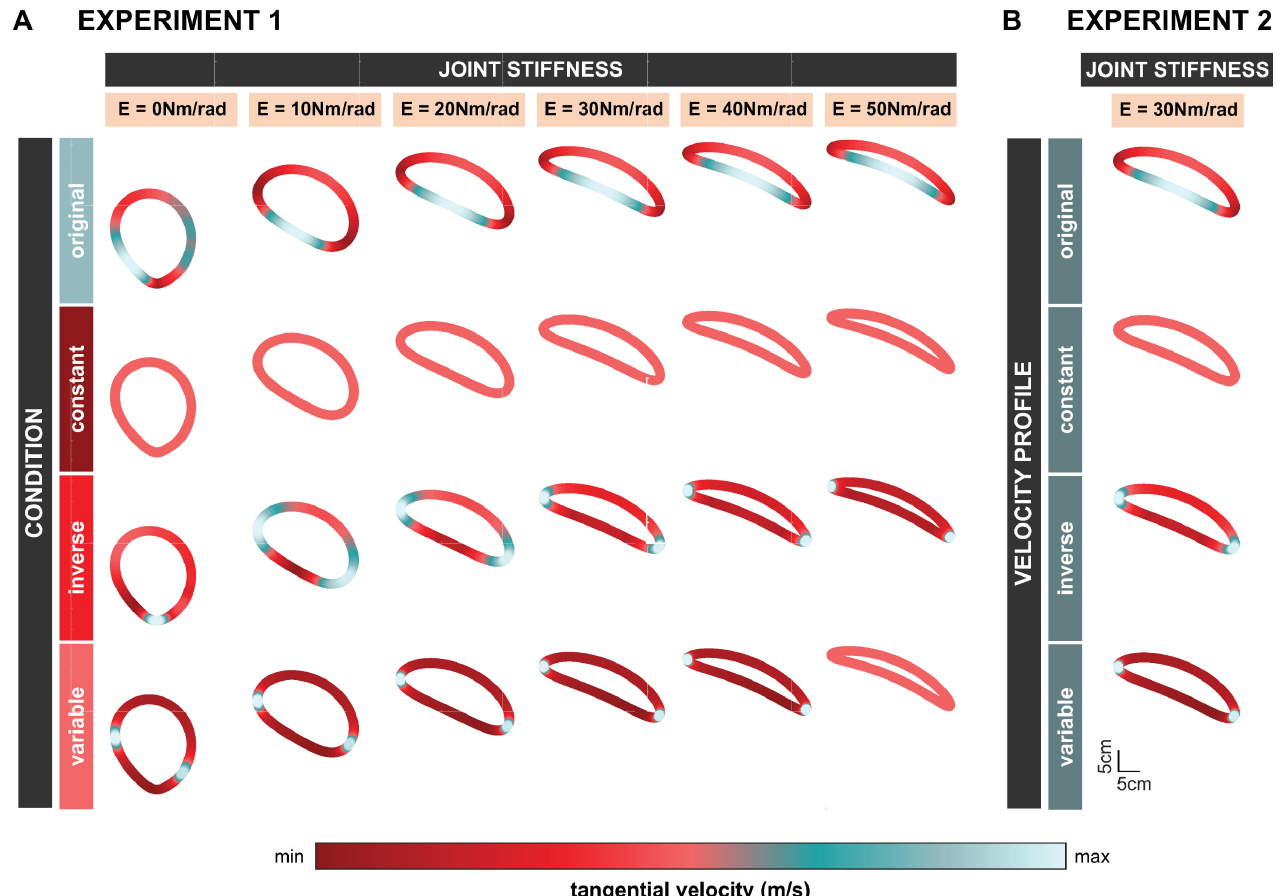
Fig 3. (A) Simulated arm motions in Experiment 1. The simulated endpoint velocity profiles for each endpoint path across all conditions in Experiment 1 are shown. In the original condition , the velocity profiles followed from the dynamic simulation. In the constant condition , the velocity profiles were manipulated to be constant. In the inverse condition , the velocity profiles were manipulated to follow the inverse of the veridical power-law relation. In the variable condition, the relation between tangential velocity and radius of curvature changed with each simulated stiffness; the velocity profiles did not have a simple velocity- curvature power-law relation (see Fig 4 ). (B) Simulated arm motions in Experiment 2. In Experiment 2, the endpoint path (and simulated stiffness) remained the same across the four different arm motions shown to participants, while the temporal pattern along the path differed. The endpoint path was generated with E = 30 Nm/rad; the velocity profiles along the path were chosen from the four conditions in Experiment 1 and are referred to as original, constant, inverse, and variable, accordingly.